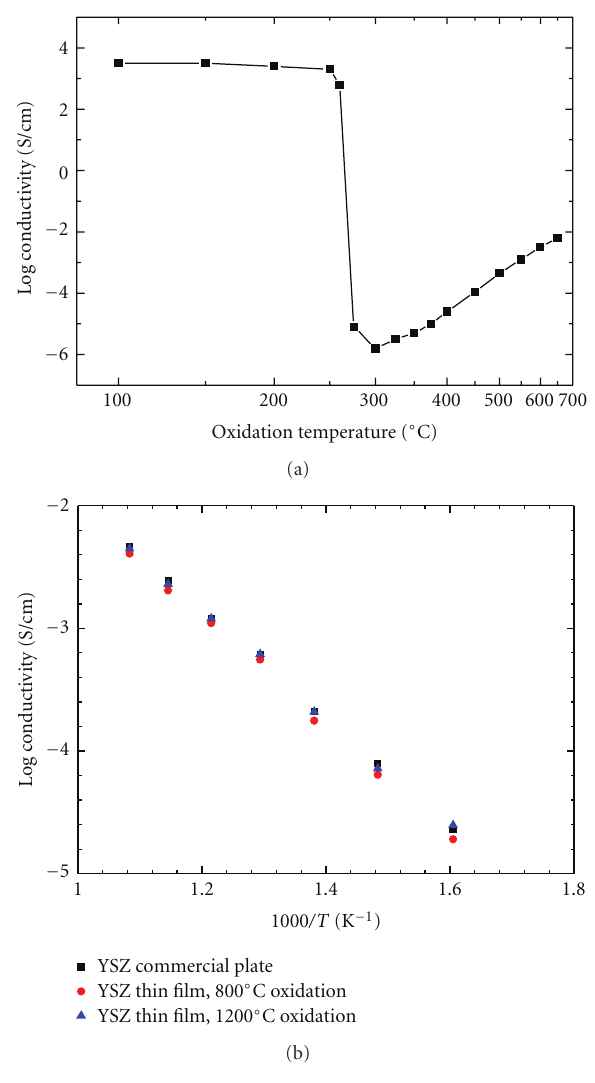
Figure 5: (a). In situ conductivities in logarithmic scale changes with thermal oxidation temperature. (b) Logarithmic conductiv- ities versus reciprocal temperatures from YSZ thin films achieved at di ff erent oxidation temperatures, that are 800 ◦ C and 1200 ◦ C, in comparison with 8YSZ commercial